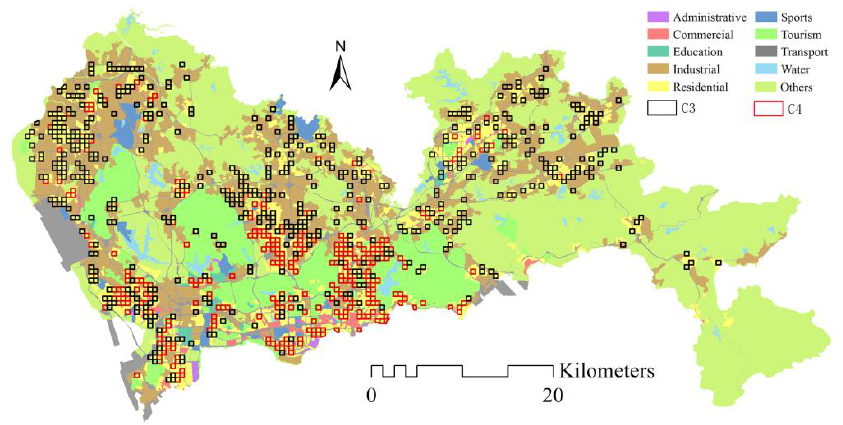
Figure 9. Spatial distributions of identified functional clusters C 3 and C